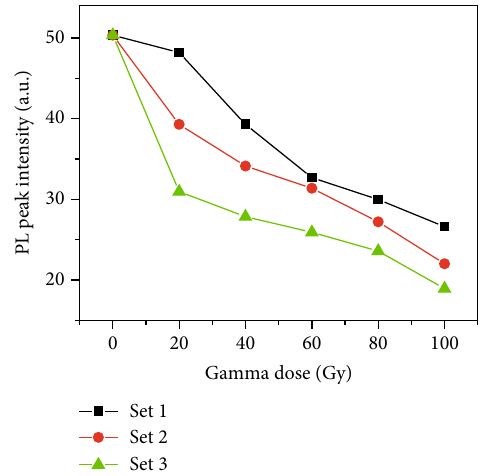
Figure 6: Variation of PL intensity with respect to gamma dose for PM-533 SSNTDs without etching.